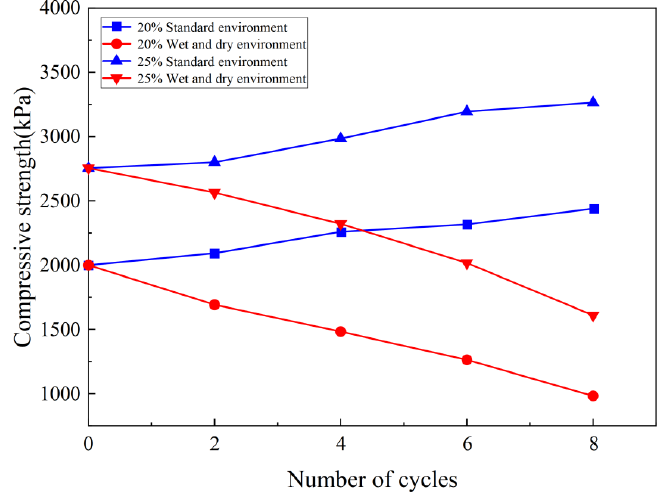
Figure 9. Variations in the compressive strengths of the samples with curing agent contents of 20% and 25% with an increasing number of wet–dry cycles.